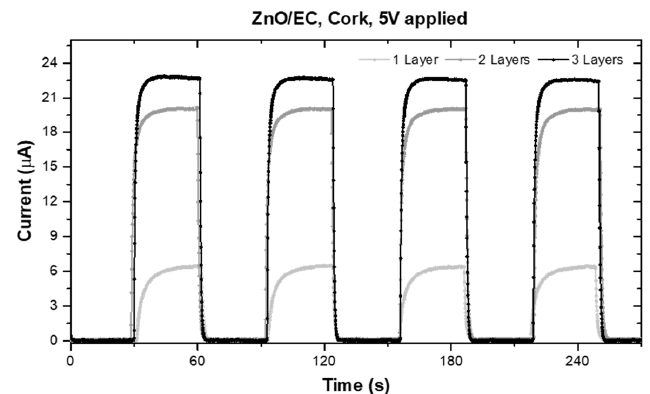
Figure 3. Photoresponse of printed UV-sensitive films, differing in the number of ZnO–EC layers.